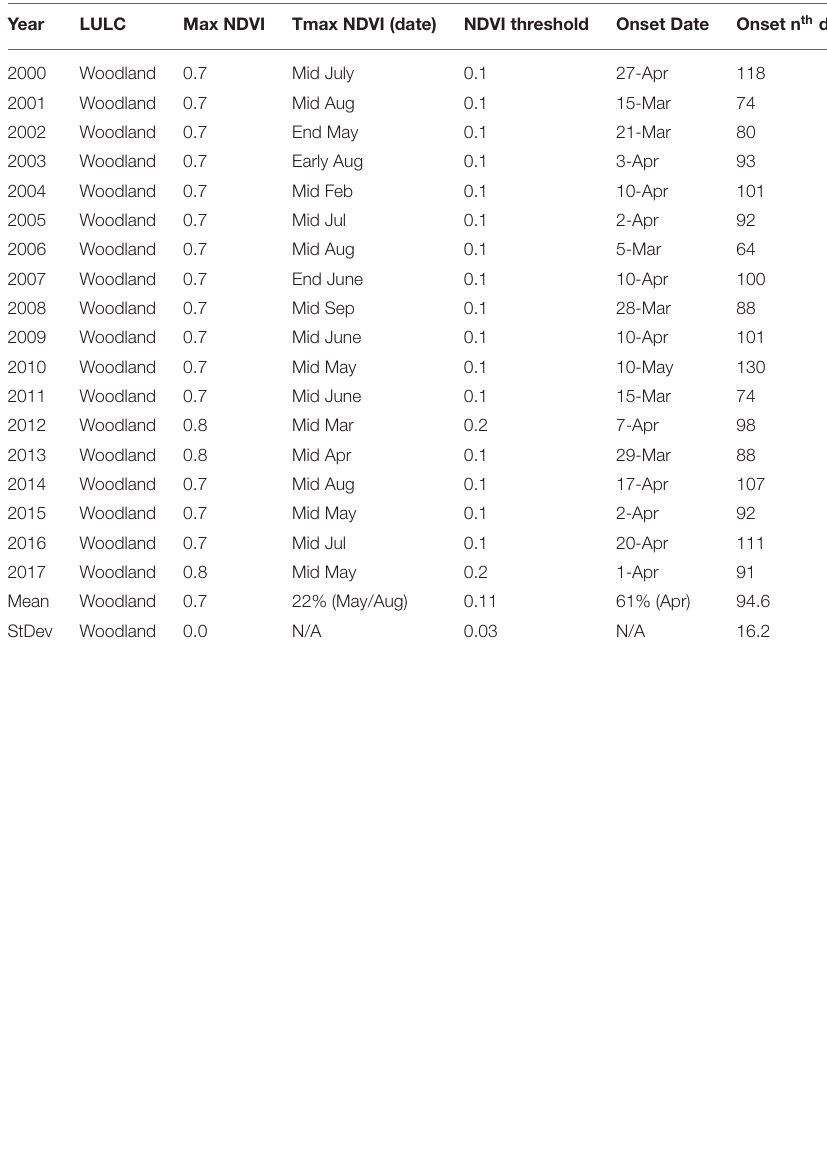
TABLE 4 | Woodland phenological metrics for the Karamoja region in Uganda for the period